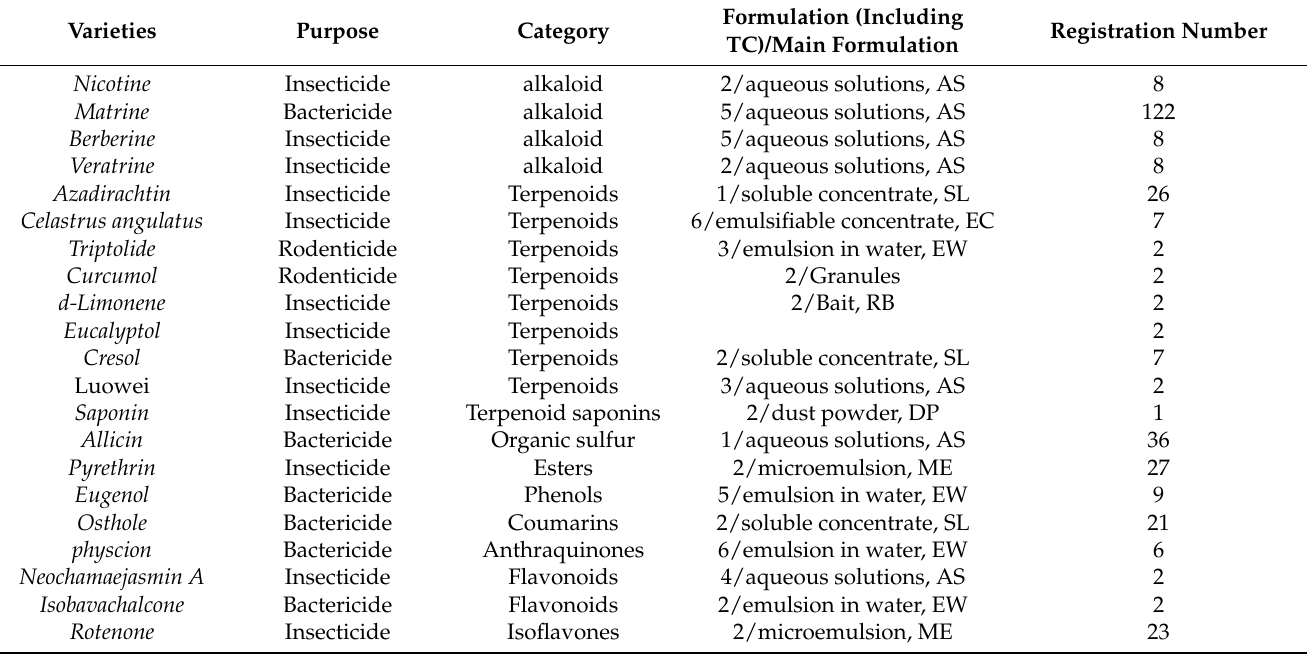
Table 2. Registration information of botanical pesticides in